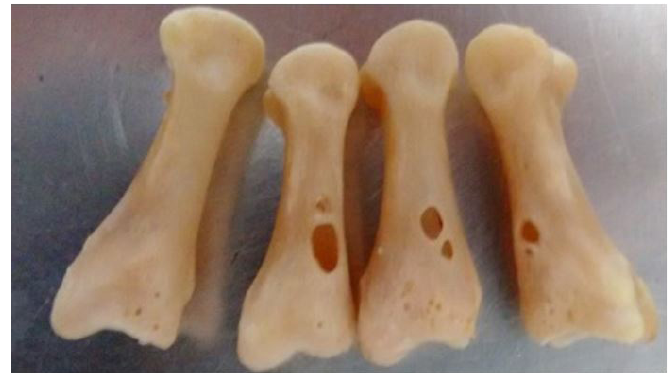
Figure 11. Proximal phalanges with evidence of demineralization.